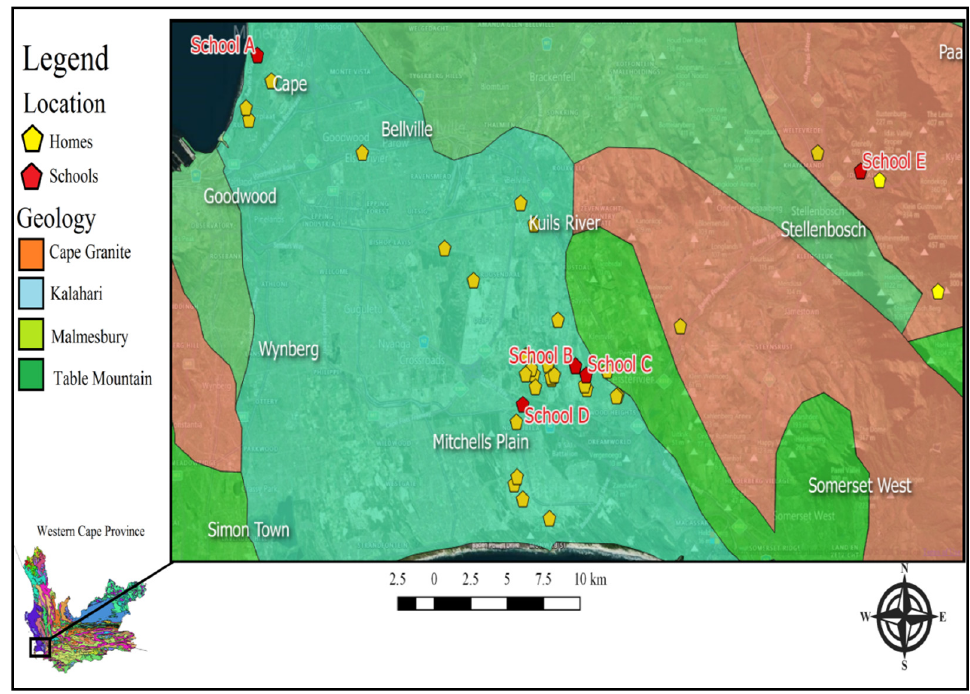
Figure 2. Cape Flats map showing measurement locations of schools and homes and the surrounding geology.